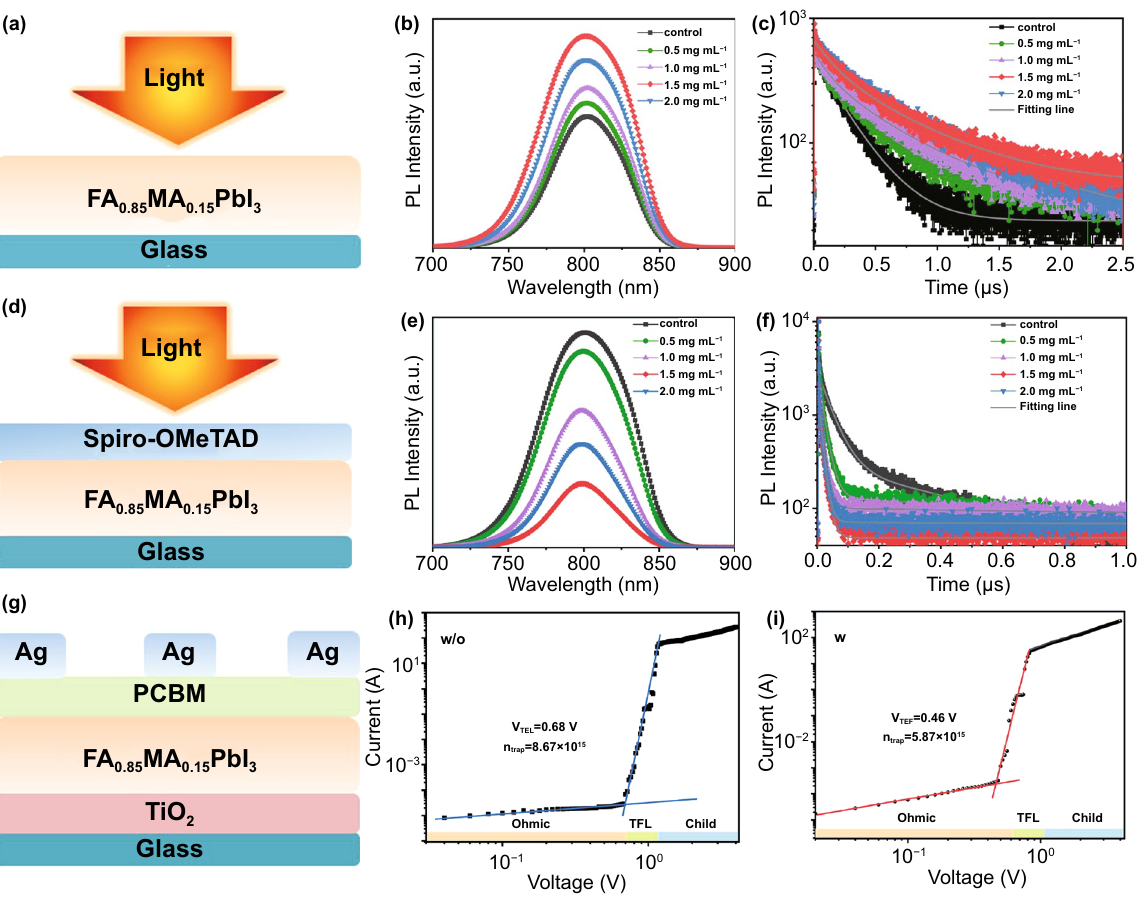
Fig. 5 a Schematic of film architecture (perovskite/glass) for PL measurements. b Steady-state PL spectra and c PL decay curves of perovskite films with and without BBF additive. d Schematic of film architecture (Spiro-OMeTAD/perovskite/glass) for PL measurements. e Steady-state PL spectra and f PL decay curves of Spiro-OMeTAD/perovskite/glass. The space-charge-limited current versus voltage of g devices (FTO/TiO 2 / perovskite/PCBM/Ag) fabricated h without and i with BBF